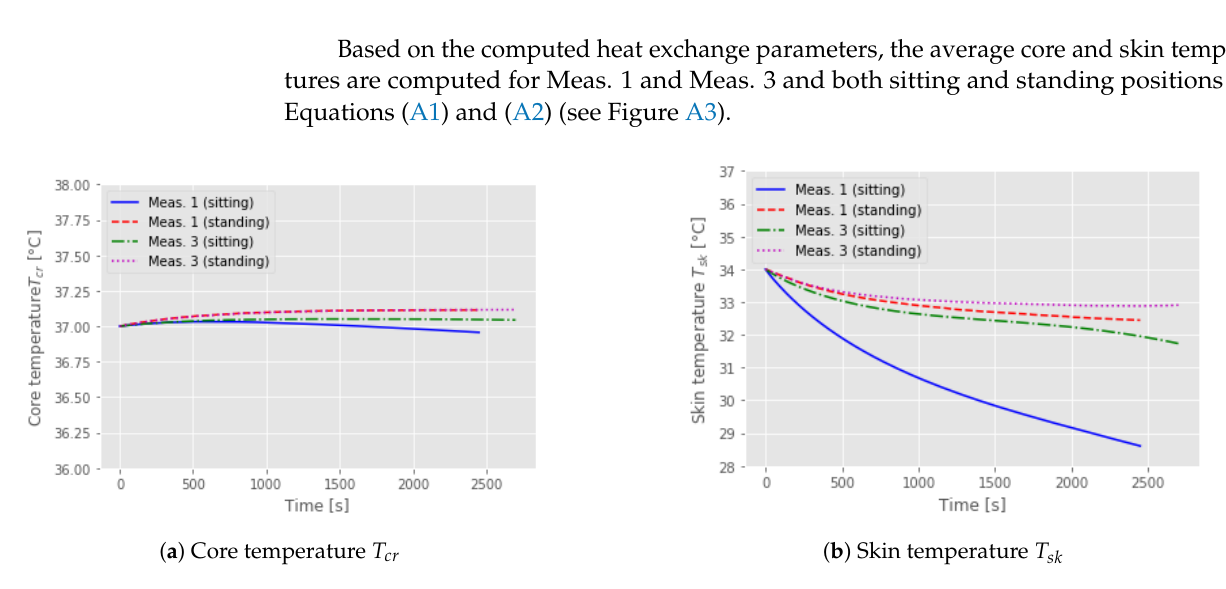
Figure A3. Computed average ( a ) core and ( b ) skin temperatures for Meas. 1 and Meas. 3 and both sitting and standing